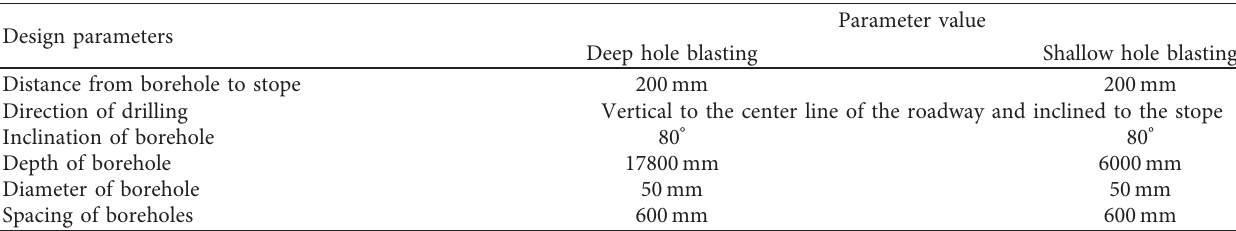
Figure 7: Scheme of deep hole and shallow hole blasting. (a) Front view. (b) Side view. (c) Vertical view. (d) Schematic diagram of charging explosives for deep hole blasting. (e) Schematic diagram of charging explosives for shallow hole blasting. Table 2: Parameters of blasting presplitting